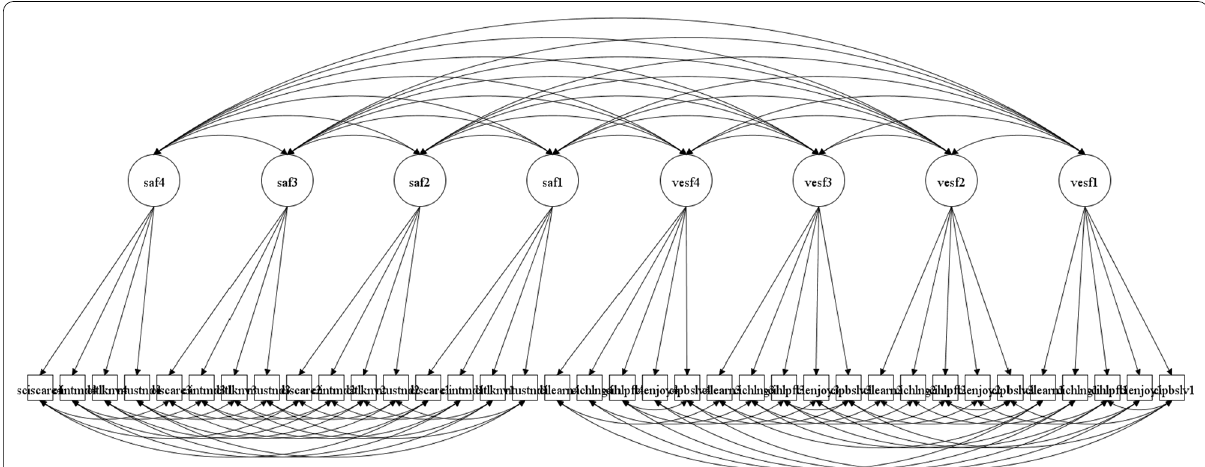
Fig. 2 Longitudinal factor structure of science value and enjoyment factor and science anxiety factor. ‘vesf’ is the value and enjoyment of science factor and ‘saf’ is the science anxiety factor; the number after factor names denote time point, for example, ‘saf4’ means the SAF at time